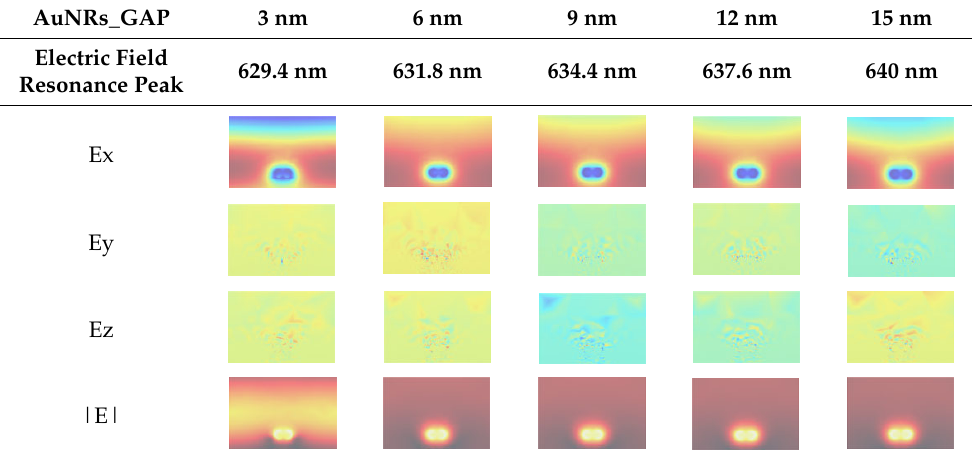
Table 1. Electric field distribution under the resonance peak of the gold nanorod dimer in the jux- taposed structure (Y-Z section).